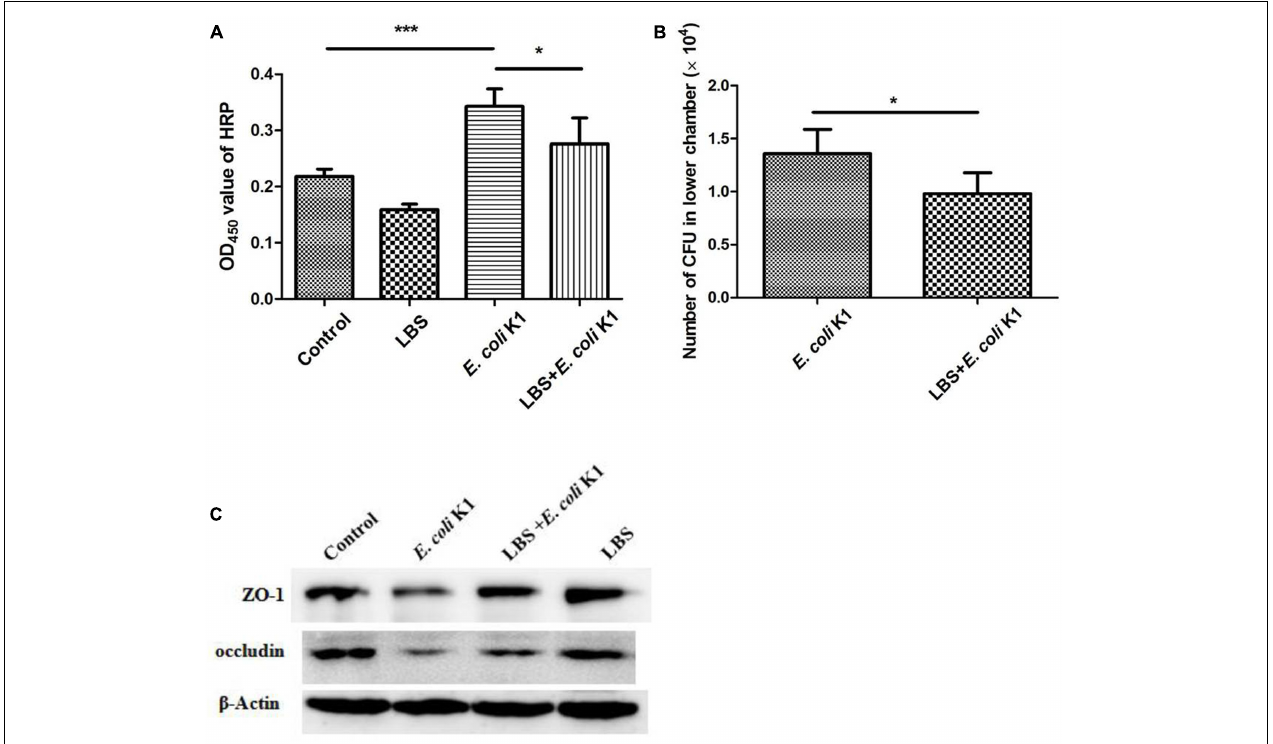
FIGURE 4 | Lactobacillus bulgaricus , Bifidobacterium, and Streptococcus thermophilus prevents E. coli K1-induced disruption of intestinal integrity. HT-29 cells were cultured on the upper chamber of the Transwell insert and pre-treated with or without LBS before E. coli K1 infection. Cells treated with PBS or LBS alone were served as controls. After infection, HRP was added to the upper chamber of Transwell for 1 h. Bacteria and HRP translocated from the upper chamber to the lower chamber were quantified as described in section “Materials and Methods.” (A) The OD 450 value of HRP. (B) The number of E. coli K1 CFU, which penetrated across the HT-29 monolayer. Results are represented as mean ± SD. ∗ P < 0.05, ∗∗∗ P < 0.001. (C) HT-29 cells were treated as described in Figure 1 , proteins of each group were isolated for western blotting. The expressions of ZO-1 and occludin was determined, β -Actin band was used as an indicator of protein loading.